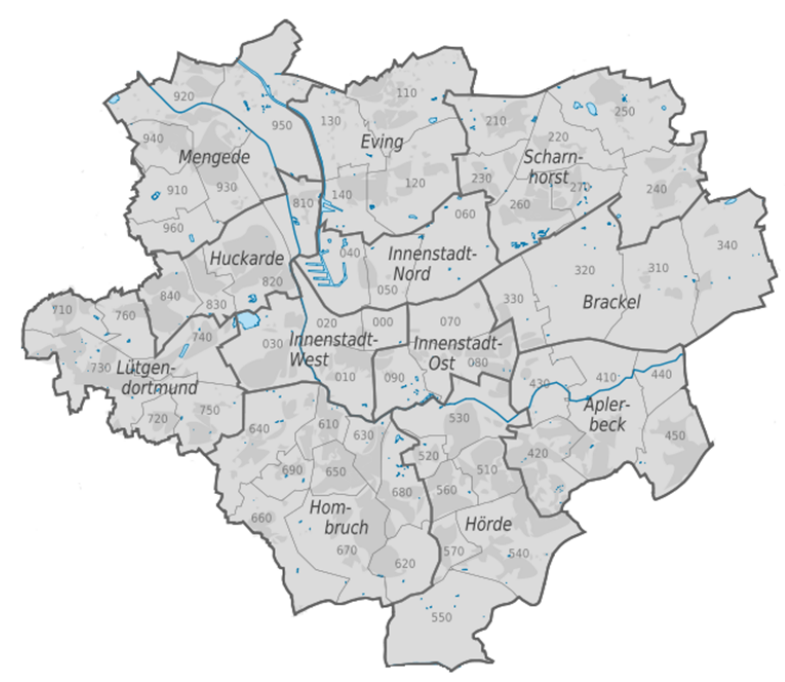
Figure 4. The map of city of Dortmund with its codified